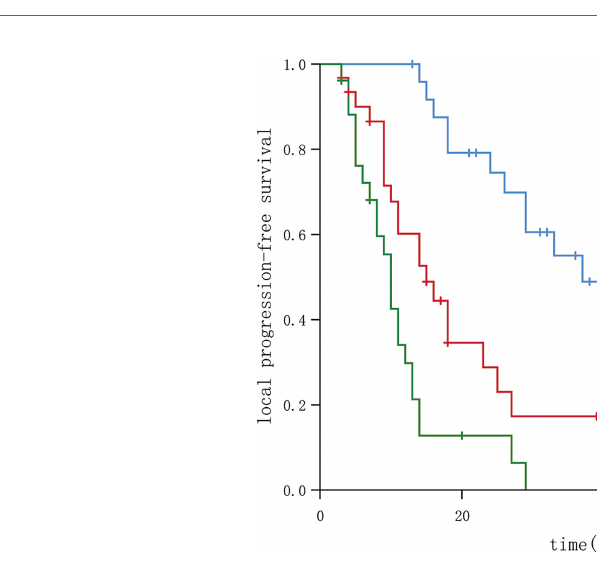
FIGURE 4 | Local progression-free survival in patients following strati fi cation by risk factors (P <